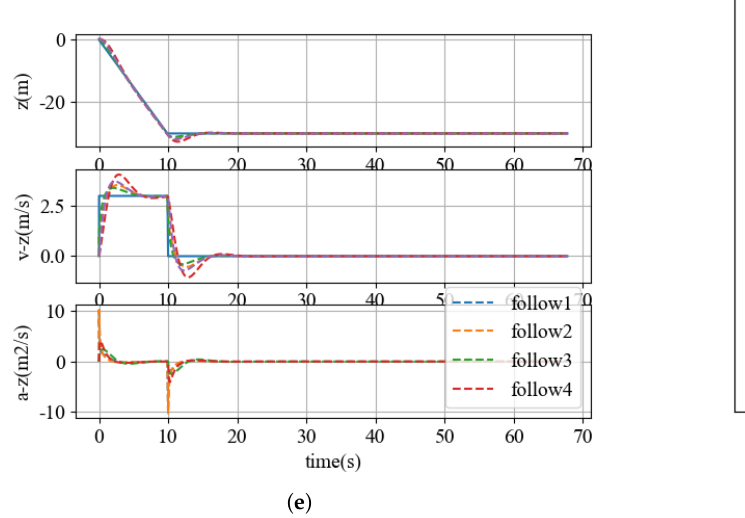
Figure 3. ( a ) HOAUVs’ formation (2-D); ( b ) HOAUVs’ formation (3-D); ( c ) state in x-direction (HOAUVs); ( d ) state in y-direction (HOAUVs); ( e ) state in z-direction (HOAUVs); ( f ) event trigger time (HOAUVs).